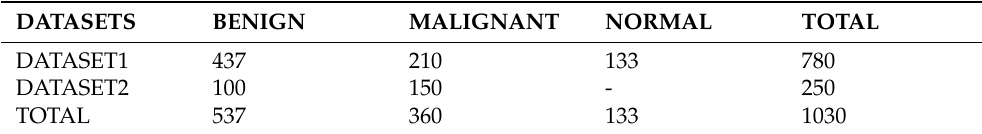
Figure 1. BC ultrasound images from dataset. Table 1. Detail of BC dataset.